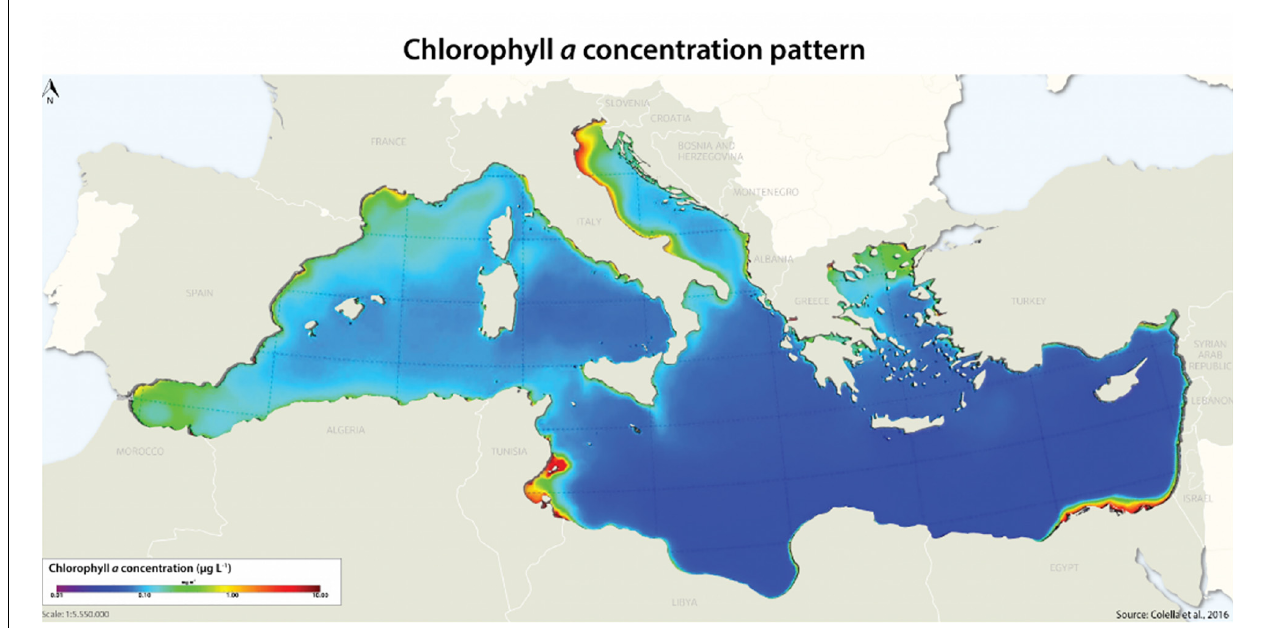
FIGURE 1 | The Mediterranean basin and chlorophyll concentration patterns as an indicator of productivity (from Colella et al., 2016).